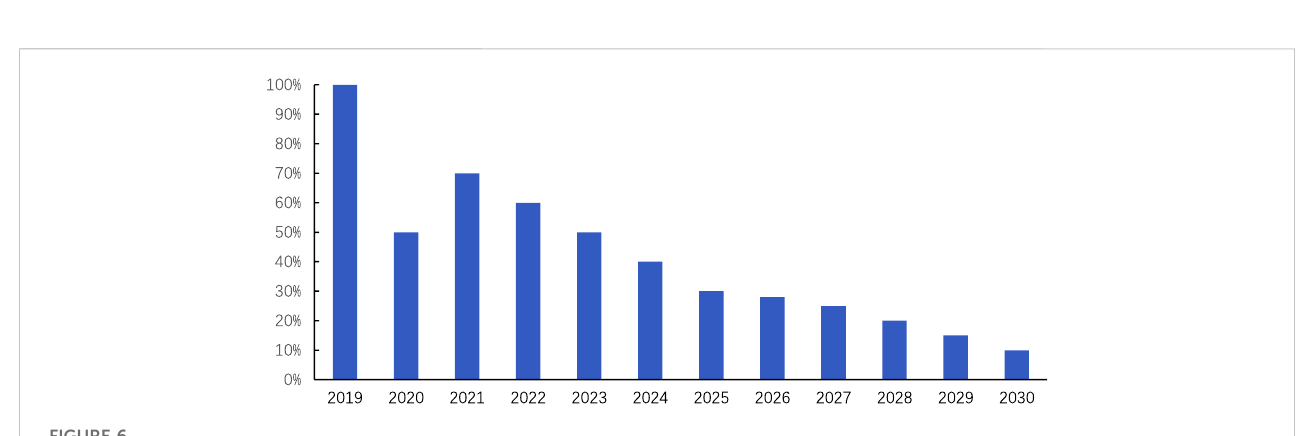
FIGURE 6 Emission trend from 2019 to 2030 (based on the 2019 carbon